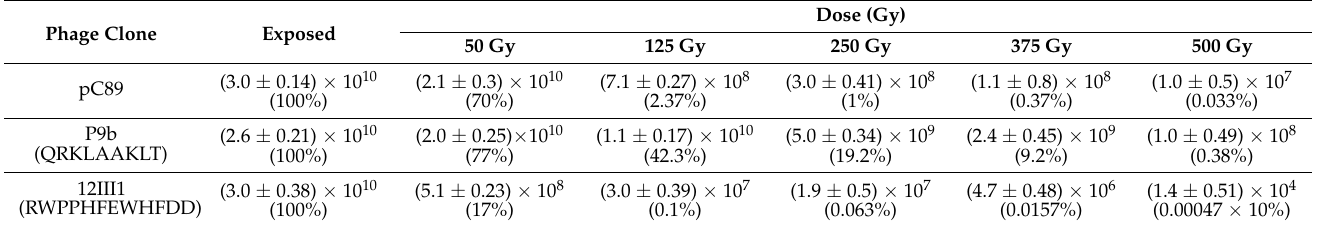
Table 2. Active virus particles of pC89, P9b and 12III1, expressed as transducing unit per milliliter of infected E. coli (TU/mL), at different dose (Gy) of 5 MeV proton irradiation. In brackets are survival percentages compared to exposed phages. Each value has been derived as averages from 5 replicates with standard deviations.